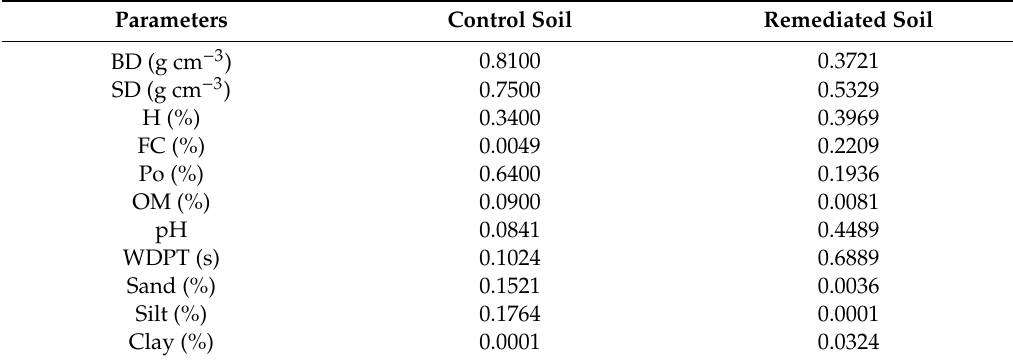
Table 3. Coe ffi cient of determination (R 2 ) between residual TPH concentration and soil physical chemical